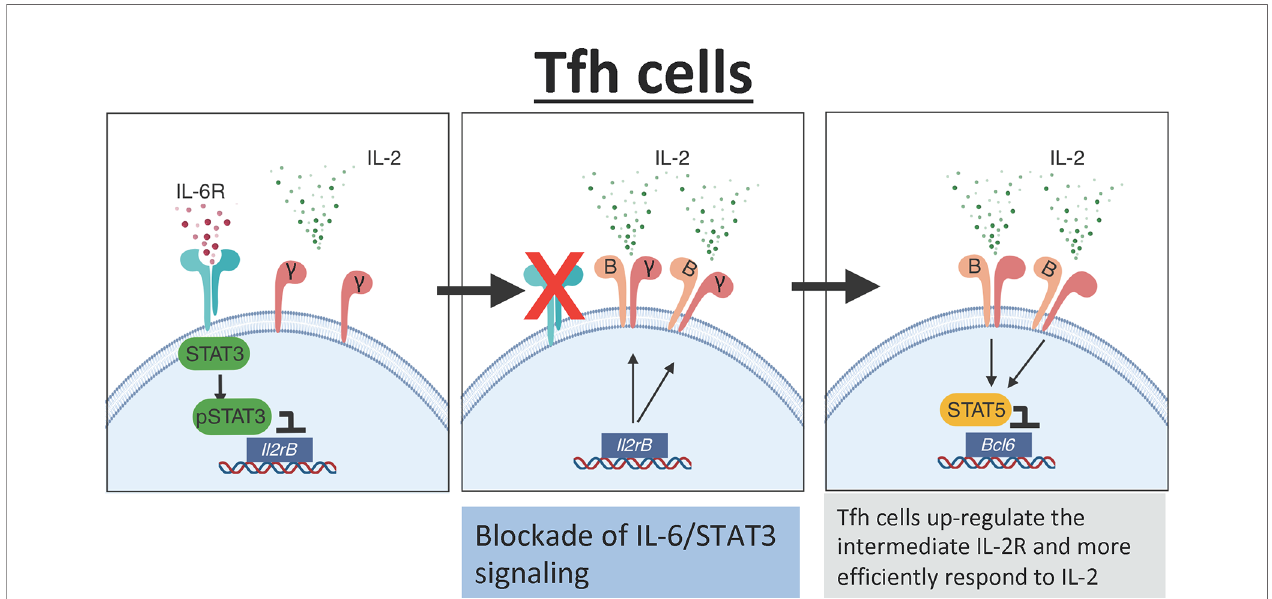
FIGURE 3 | IL-6 mediates the IL-2 responsiveness of Tfh cells. In the presence of IL-6 signaling, Tfh cells activate STAT3 which directly binds to the Il2rb promoter preventing expression of CD122. Low expression of CD122 limits IL-2 signaling in Tfh cells. In the absence of IL-6 signaling, there is increased expression of CD122 on the surface of Tfh cells leading to increased responsiveness to IL-2. The increased IL-2 signaling activates STAT5 which binds to the promoter region of Bcl6 and suppresses the Tfh cell